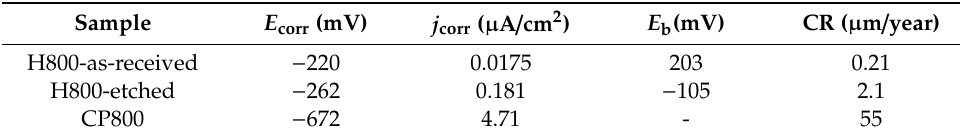
Table 2. Current density ( j corr ) and corrosion rates (CR) estimated from the potentiodynamic curves, scan rate 1 mV /